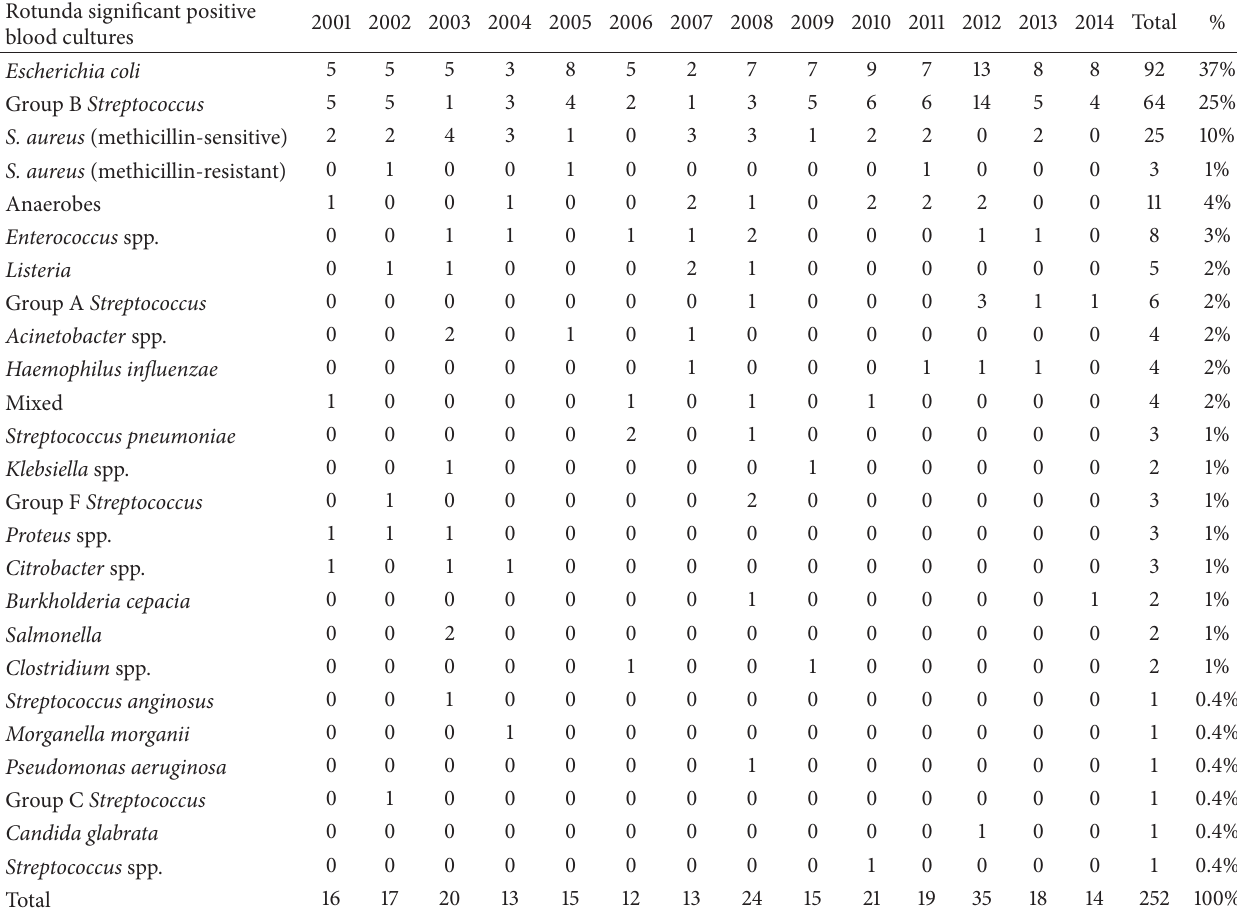
Table 1: Overview of clinically significant obstetric related positive blood cultures in Rotunda Hospital from 2001 to 2014. Rotunda significant positive 2001 2002 2003 2004 2005 2006 2007 2008 2009 2010 2011 2012 2013 2014 Total % blood cultures Escherichia coli Group B Streptococcus S. aureus (methicillin-sensitive) Anaerobes 1 Enterococcus spp. 0 Listeria 0 Group A Streptococcus 0 Acinetobacter spp. Haemophilus influenzae 0 Mixed Streptococcus